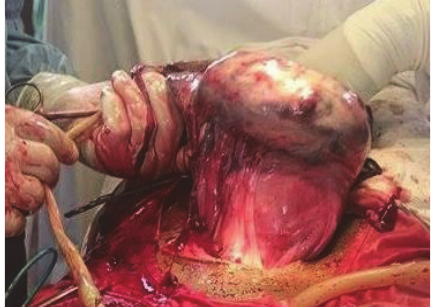
Figure 2: Normal uterus with the placenta implanted on the posterofundal